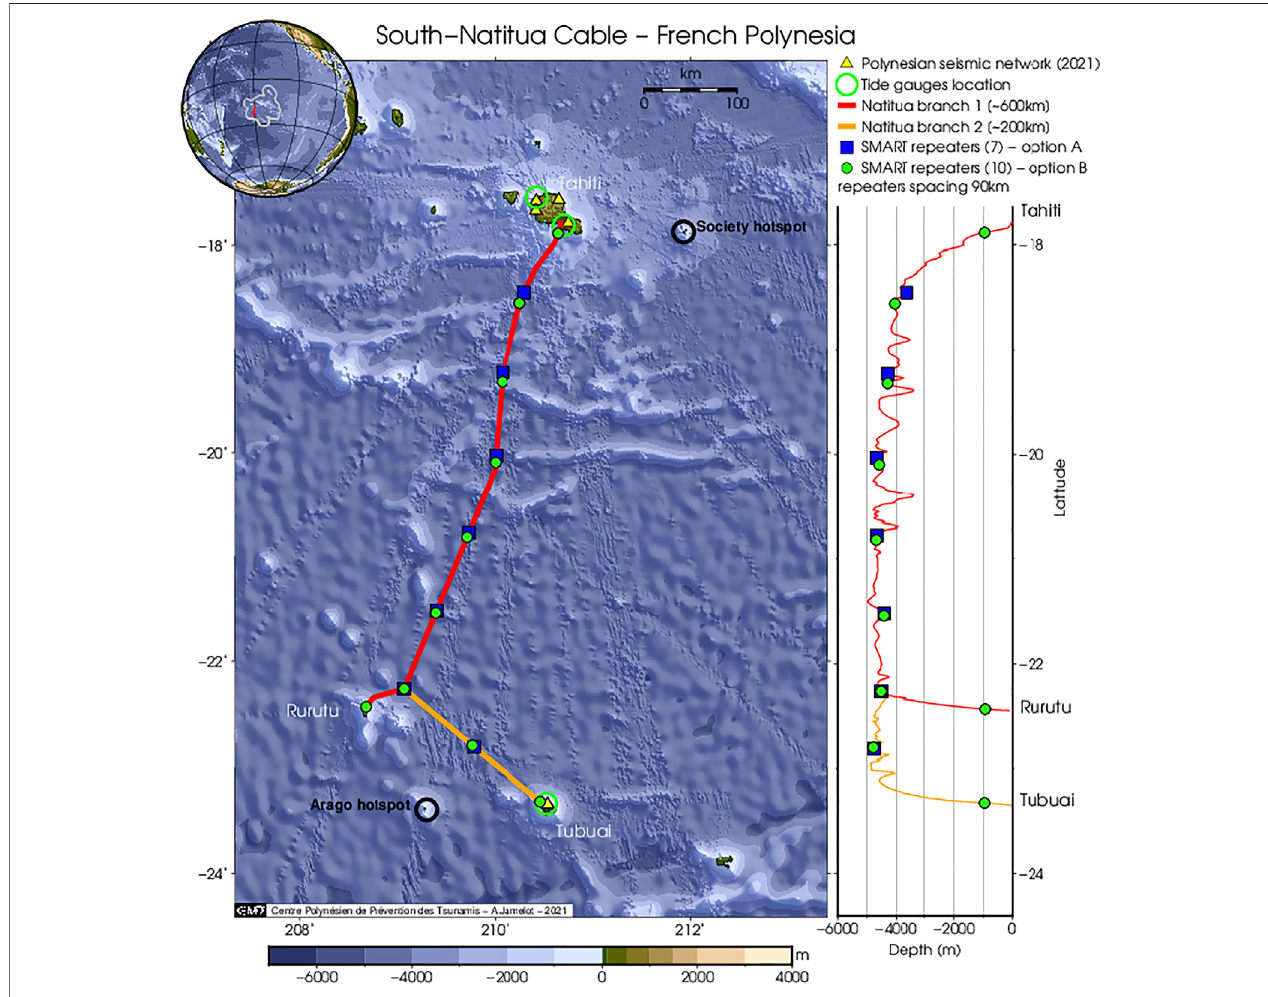
FIGURE 11 | The Natitua Cable two branch path con fi guration with a repeater spacing of 90 km along the cable (blue squares). Solid green markers represent a proposeddensedeploymentofinstrumentedrepeaters.Ontherightaretheprojecteddepthpro fi lesalongeachcablepathwithrepeaterlocations.Mostrepeatersareat 5,000 mdepthsothreehavebeenadded at1,000 mdepthneareachisland. Theperimeter ofthehotspotismarkedbyablackcircle.Opengreencircles represent tide gauge locations and yellow triangles mark existing onshore seismic stations.